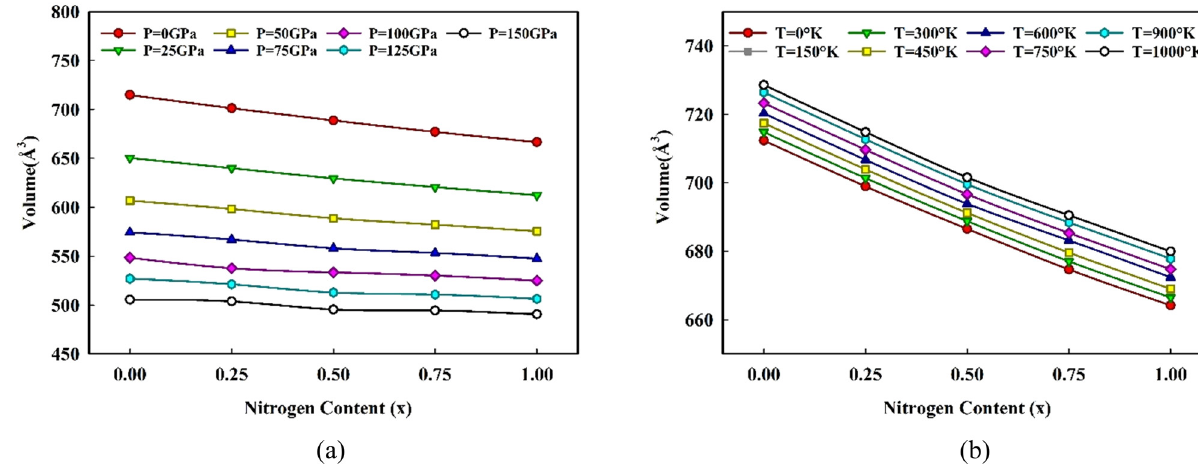
Figure 2: The volume of ZrC ( 1 − x ) N x as a function of nitrogen content ( x ) , ( a ) pressures, and ( b )